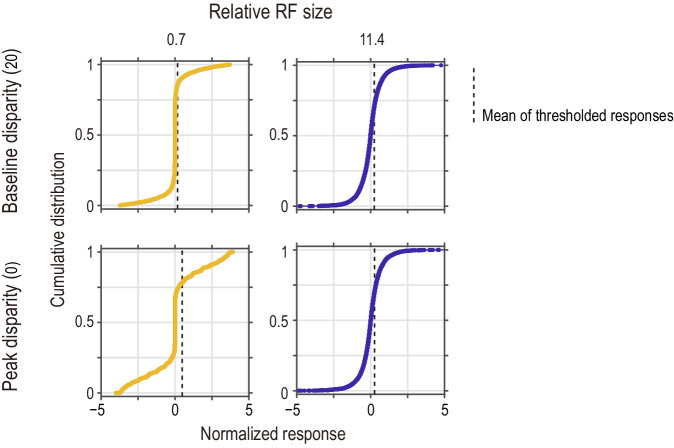
Distributions of instantaneous (frame-wise) responses of the standard energy model to half-matched RDSs.The response distribution is shown for two relative RF sizes (small and large for the left and right columns, respectively) and for two disparity values (tuning baseline and peak for the top and bottom rows, respectively). Vertical dashed lines indicate the mean computed for the half-wave rectified responses (i.e., responses of the threshold energy model). Their horizontal positions in the top-row panels correspond to the vertical levels of the arrows in the bottom-row panels of Figure 9C. The response distribution was sensitive to disparity when the relative RF size was small (left column), but not when the relative RF size was large (right column). At the baseline disparity (top row), the response was closer to zero when the RF was smaller.Figure 9—figure supplement 1—source data 1.Single-frame responses of the standard disparity energy model to half-matched random-dot stereograms.